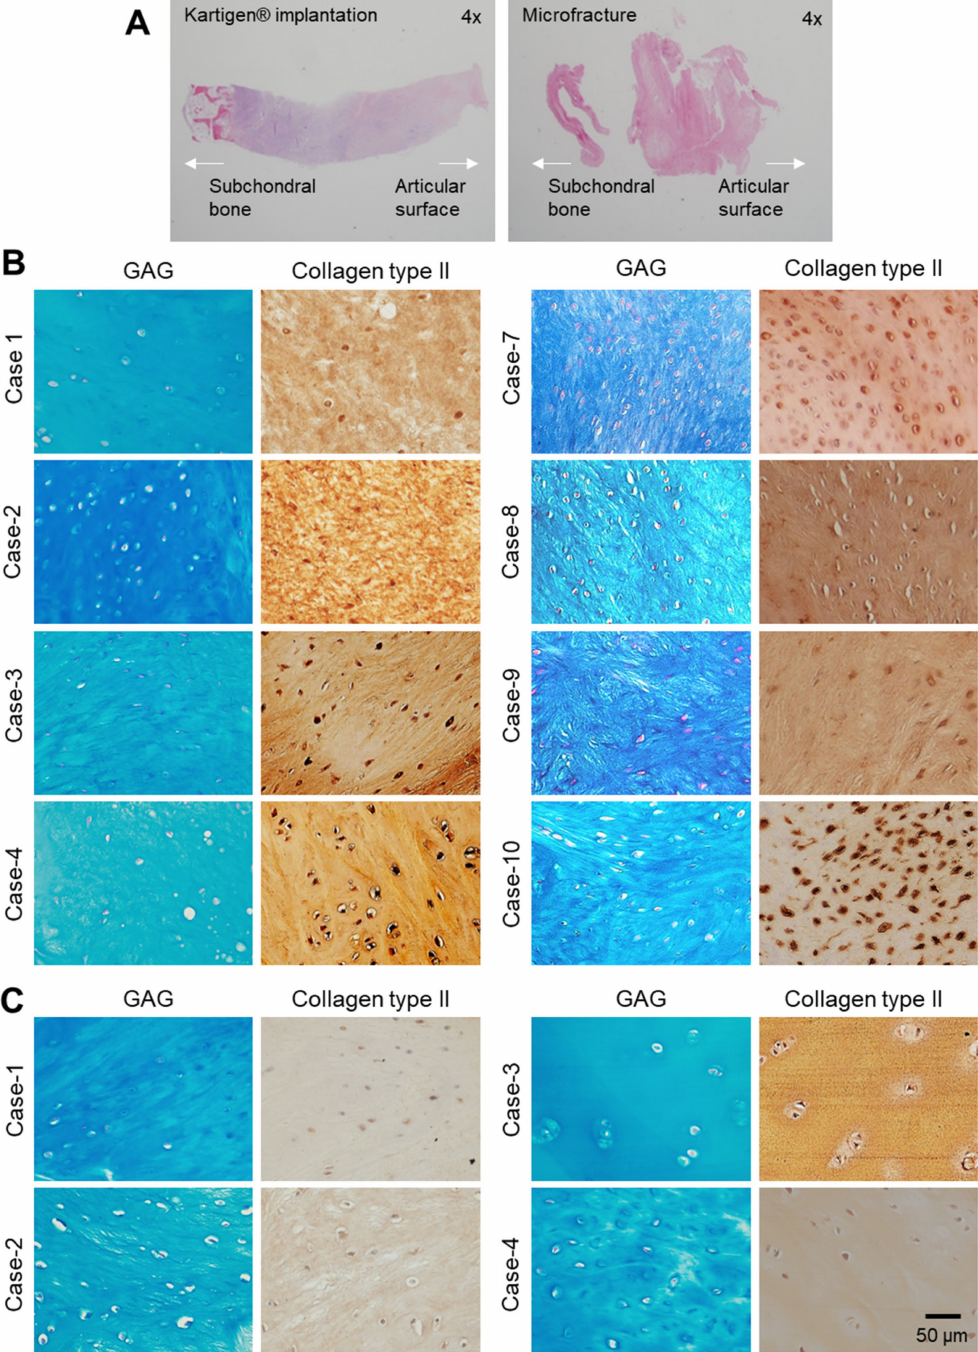
Figure 4. Immunohistochemical analyses of biopsy specimens. ( A ) Whole-slide histological images of regenerated cartilage under 4 × objective lens. Alcian blue staining and immunochemical study show expression levels of GAG/Collagen type II, respectively, in Kartigen group ( B ) and microfracture group ( C